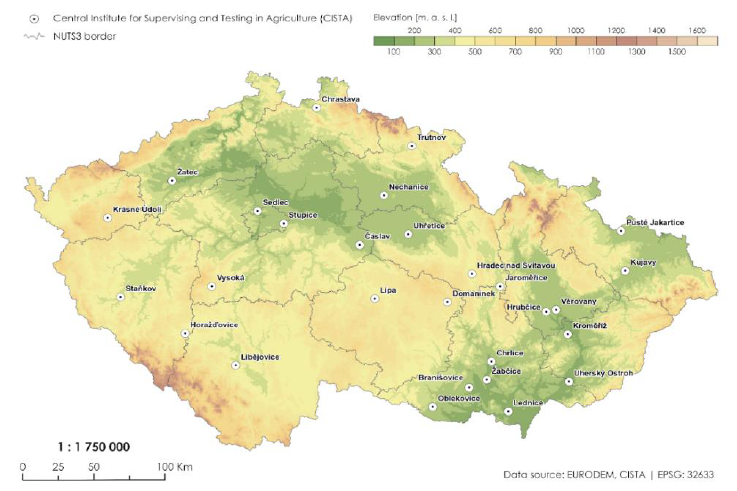
Figure 1. Overview map of the 28 stations with visual ground-based phenological observations. Table 1. An overview of the experimental stations from the Central Institute for Supervising and Testing in Agriculture with phenological observations and geographic coordinates (altitude (m.a.s.l.), latitude, and longitude), as well as the total number of years of ground phenological observations for each station. The observation stations are arranged according to altitude.